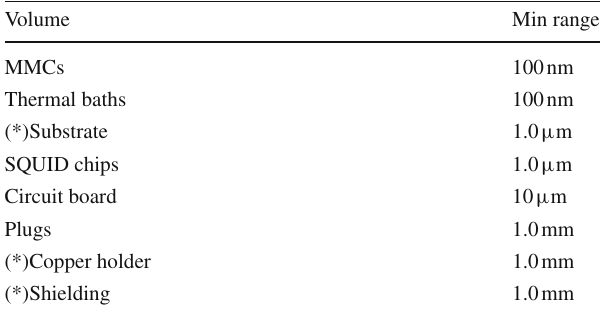
Table 3 The minimum ranges particles have to pass for different vol- umes